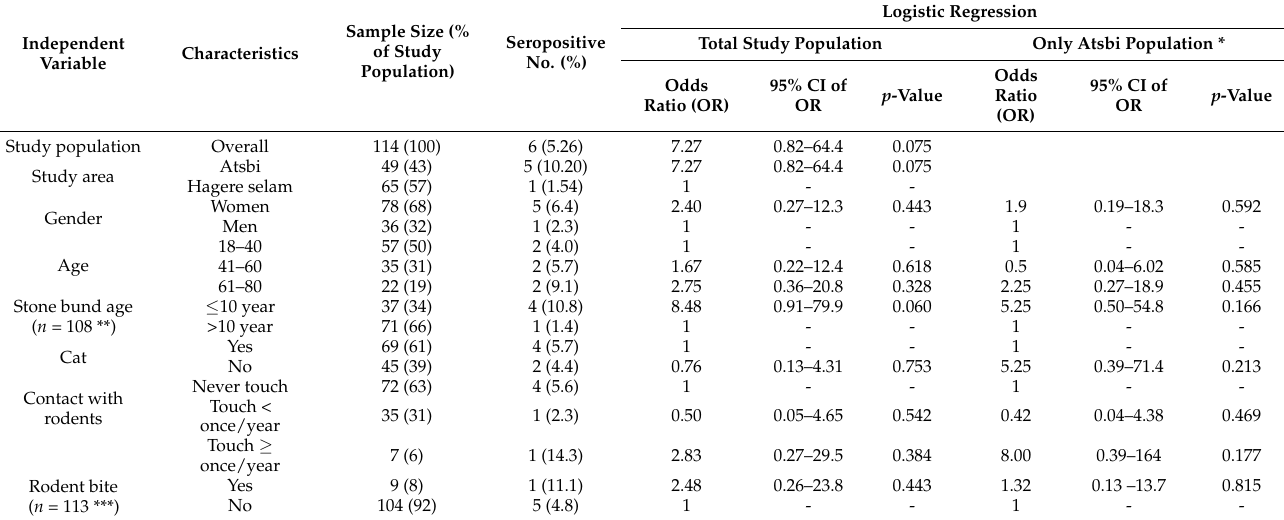
Table 4. Output from bivariate logistic regression testing the association between seropositivity and the predictor variables: Study area, Gender, Age, Stone bund age, Cat, Contact with rodents and Rodent bite.